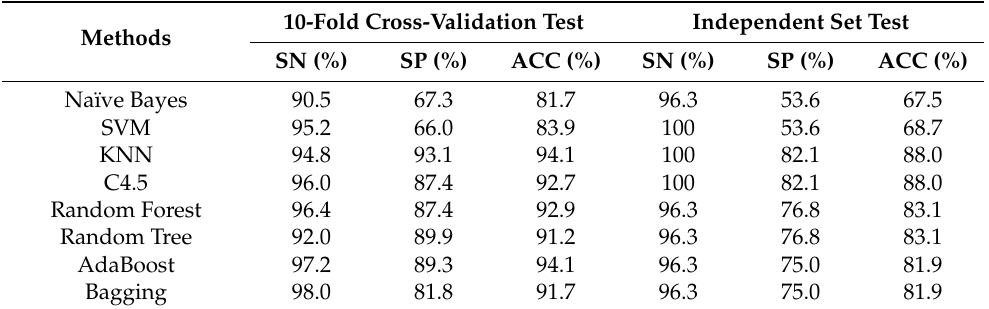
Table 1. The results of the prediction accuracy with eight molecular descriptors using different machine learning